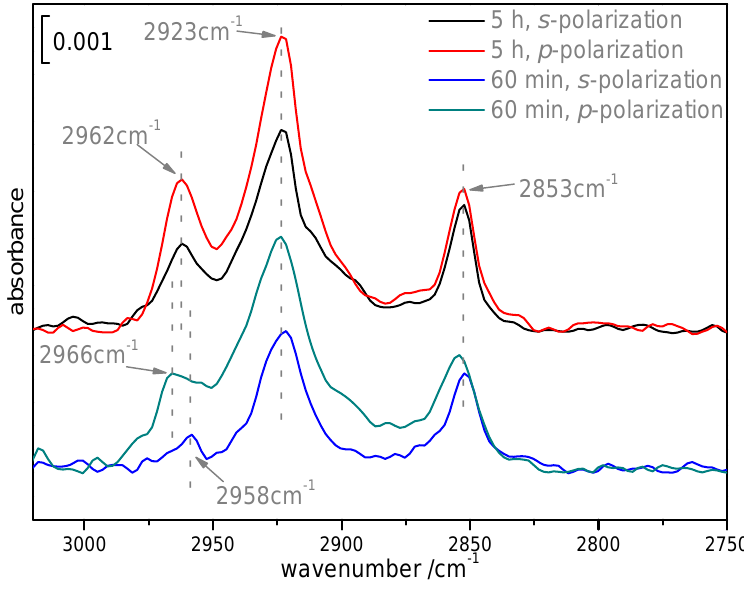
Figure 4. MTR-IR spectra at s- and p- polarizations respectively after incubation of silicon substrates in unilamellar solutions for 60 min (lower two traces) and 5 h (upper two